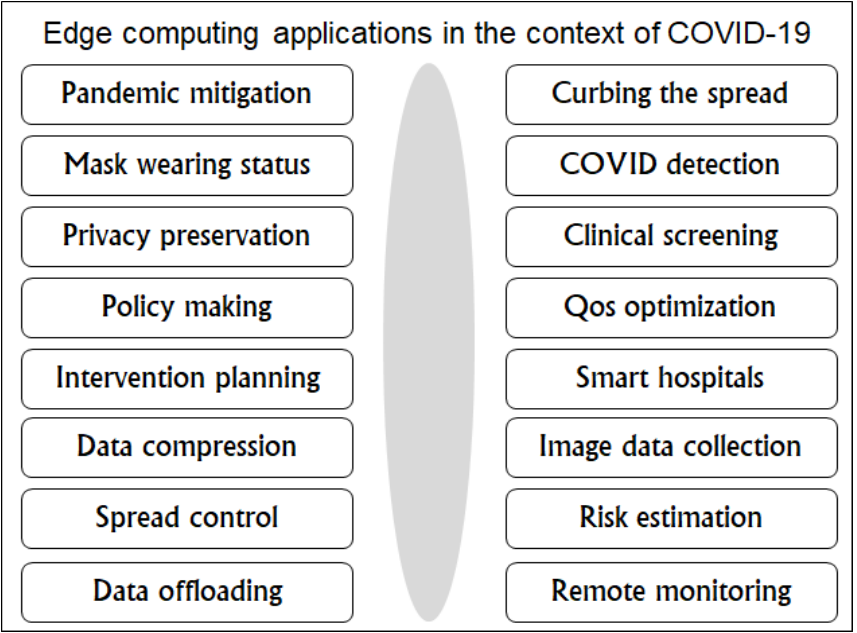
Figure 14. Applications and services of EC technology in the context of